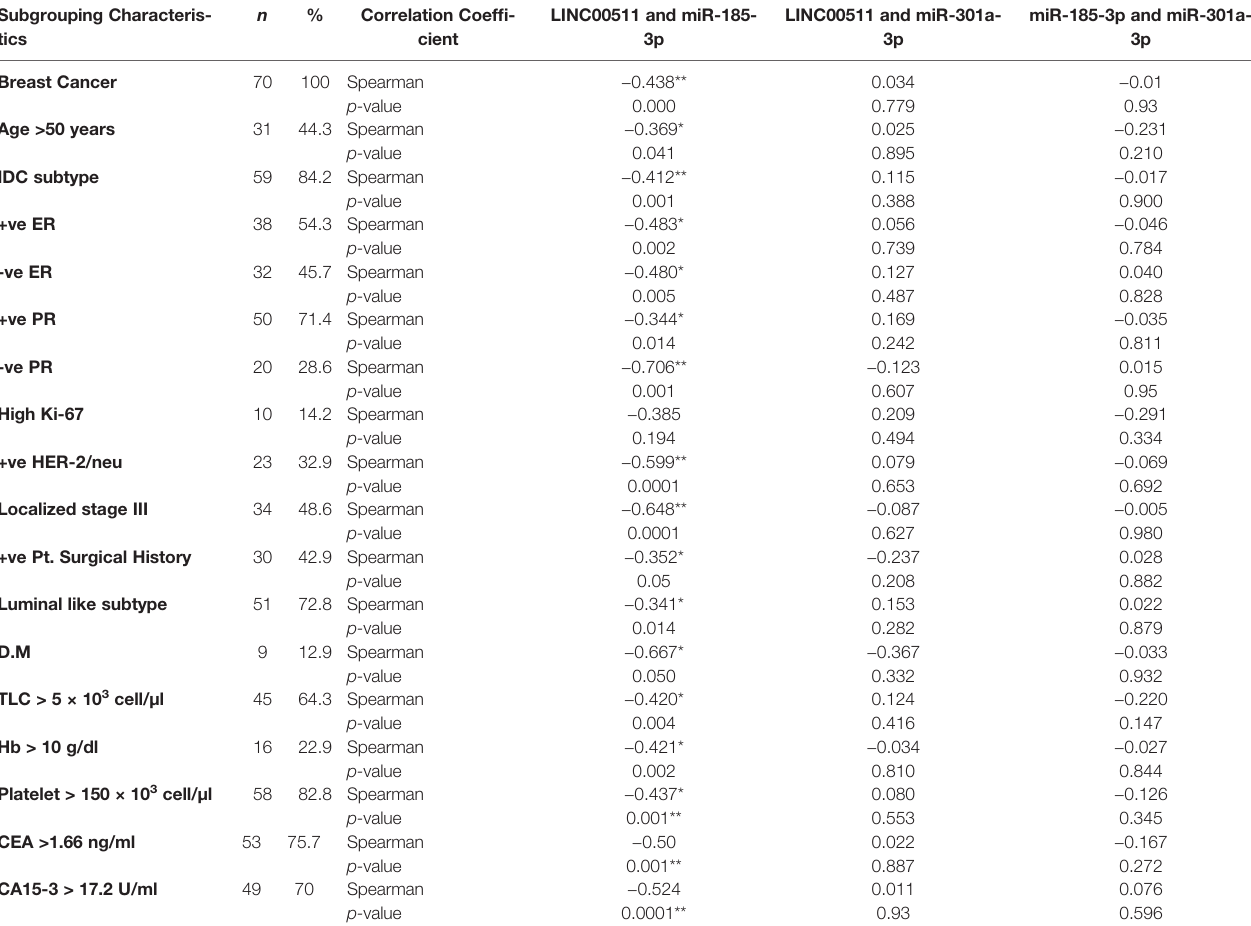
TABLE 6 | Spearman correlation coef fi cient among the combined investigated ncRNAs expression in BC group and various BC subgroups. n Subgrouping Characteris- tics Breast